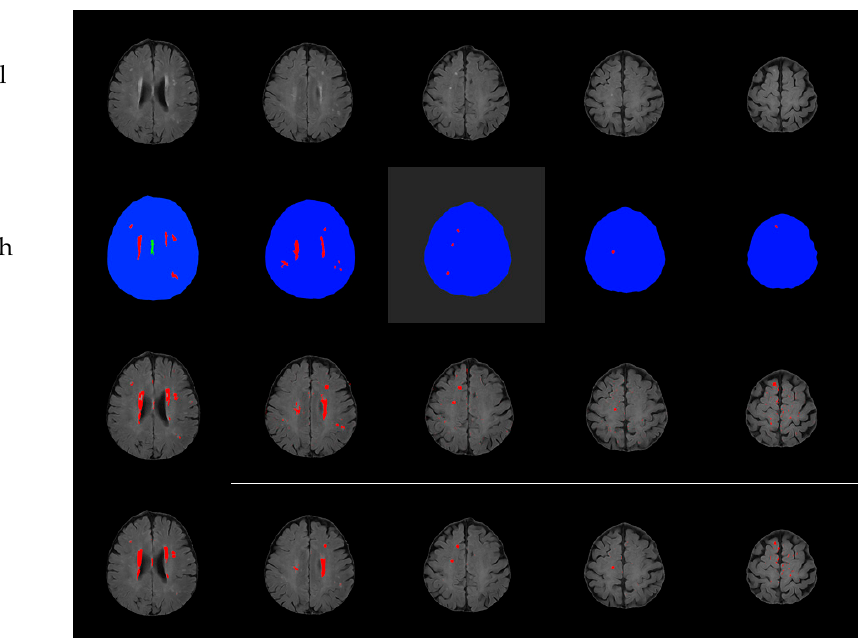
Figure 10. Comparison of CNN and MLP models.